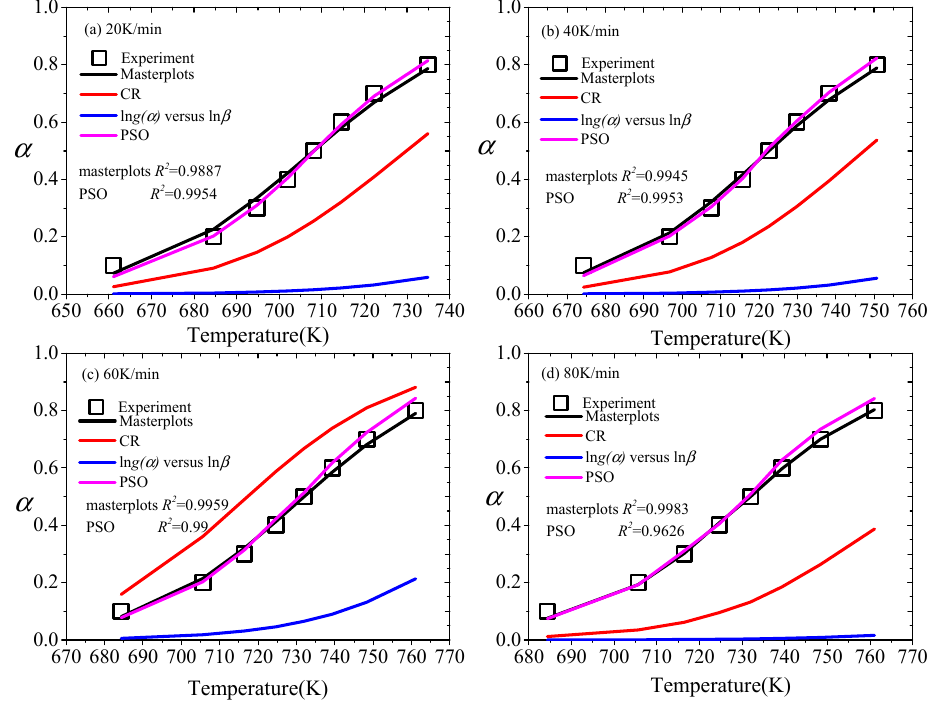
Figure 4. The α of CR, the iterative procedure, masterplots and PSO methods are compared with experimental data, ( a ) 20 K/min, ( b ) 40 K/min, ( c ) 60 K/min, ( d ) 80 K/min.